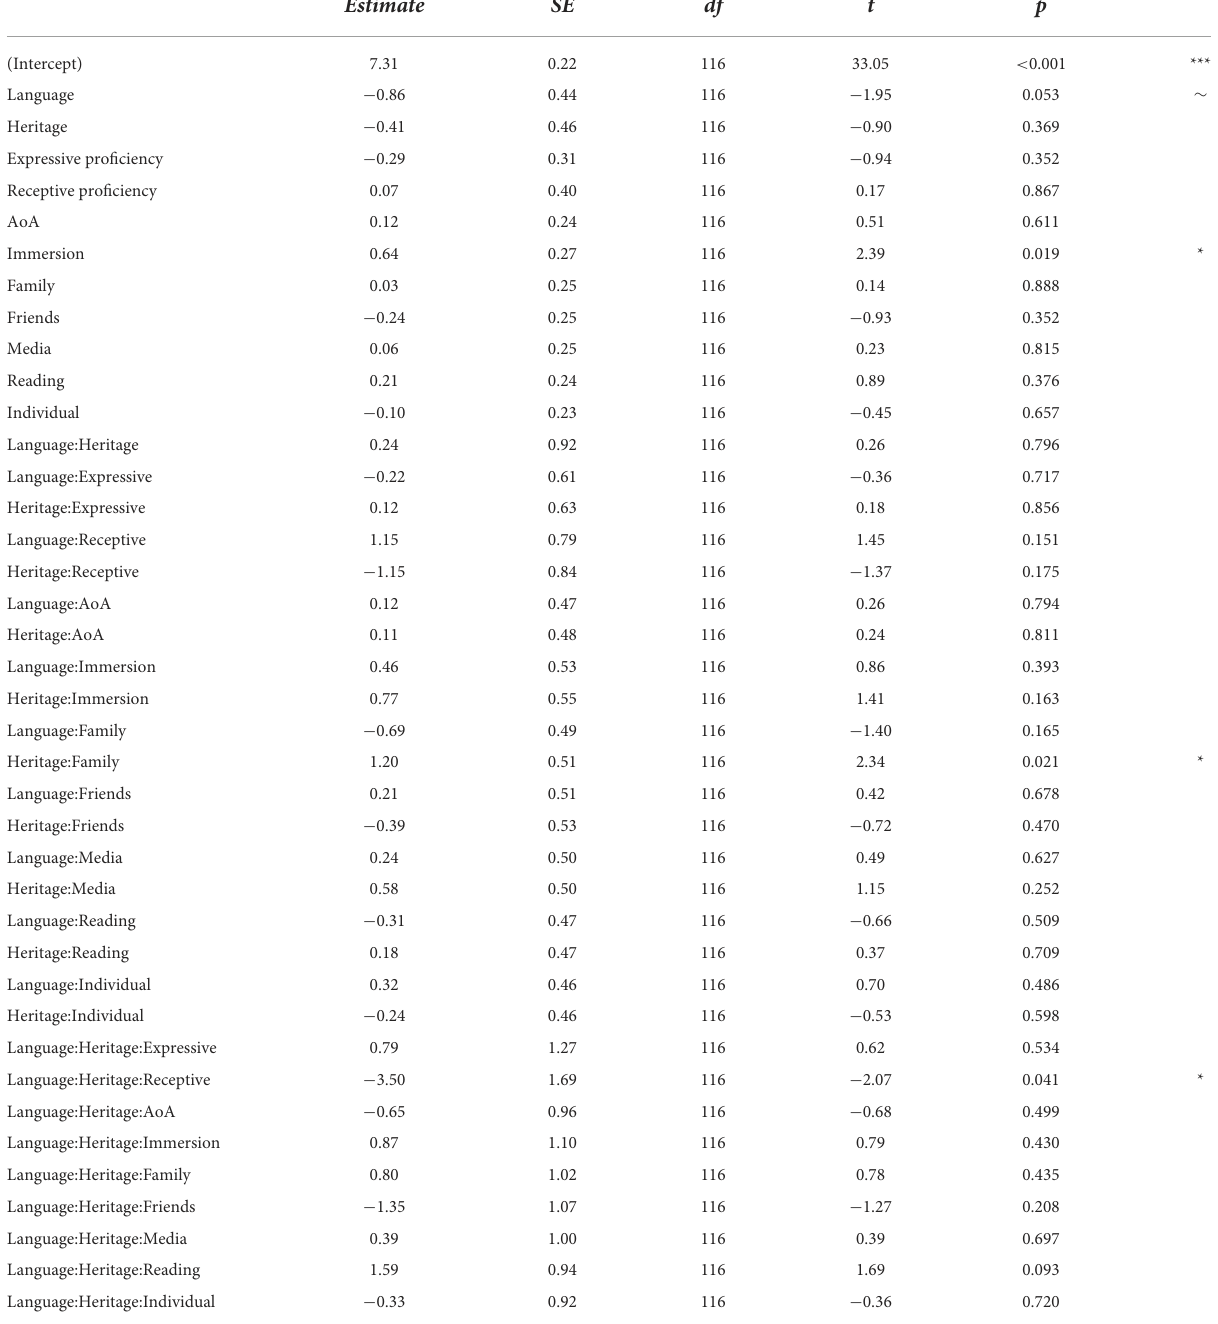
TABLE 6 Effects of relative language experience (English—HL) on heritage language and English cultural identification. Estimate SE df t